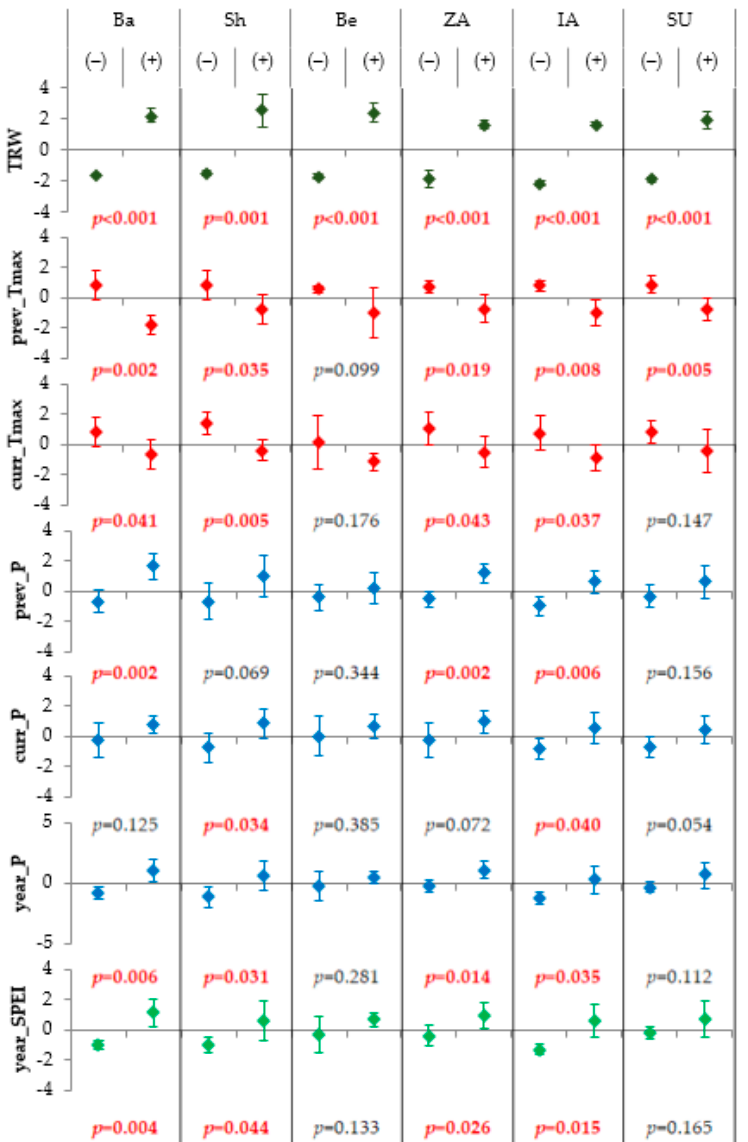
Figure 5. Characteristics of the pointer years, i.e., years with the highest/lowest tree-ring width (TRW) indices at each sampling site (Ba—Bayanaul, Sh—Shalday, Be—Beskaragay, ZA—Zhongar- Alatau, IA—Ile-Alatau, and SU—Sairam-Ugam): mean values (markers) and standard